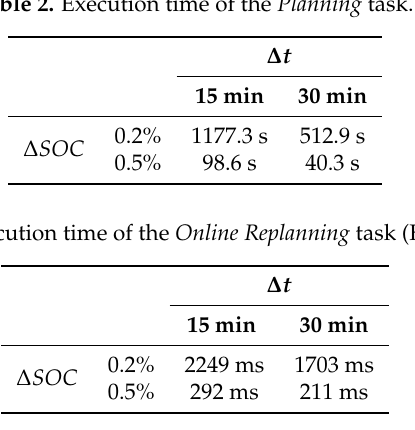
Table 2. Execution time of the Planning task.